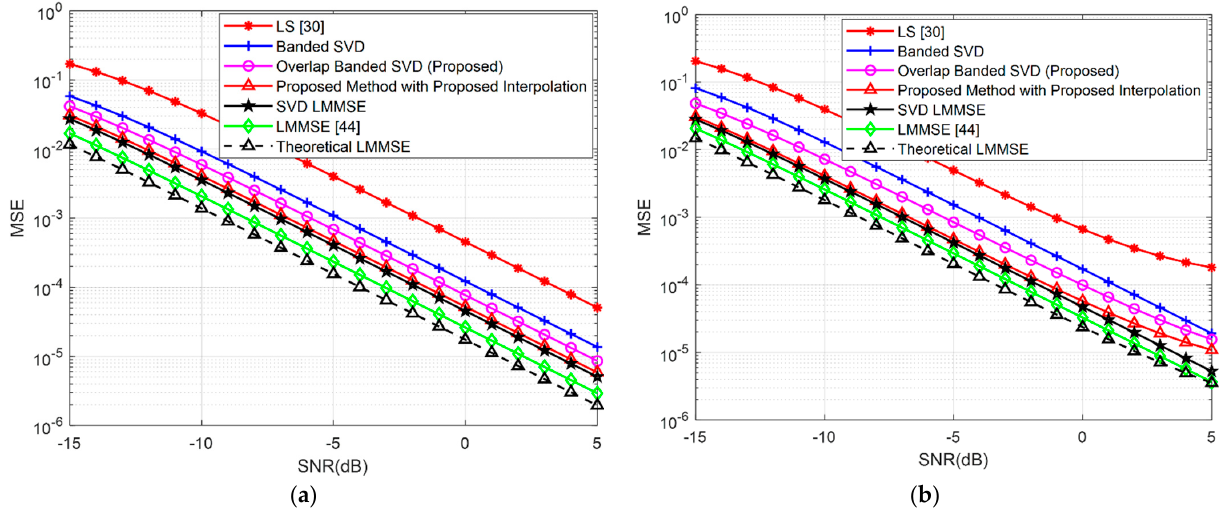
Figure 9. Mean square error (MSE) comparison of the proposed technique for conventional and proposed interpolation methods with traditional LMMSE and its other counterpart versions: ( a ) TU 1 Hz; ( b ) EPA 1 Hz. Table 4. Received SNR (dB) at MSE = 10 − 3 for different channel estimators.